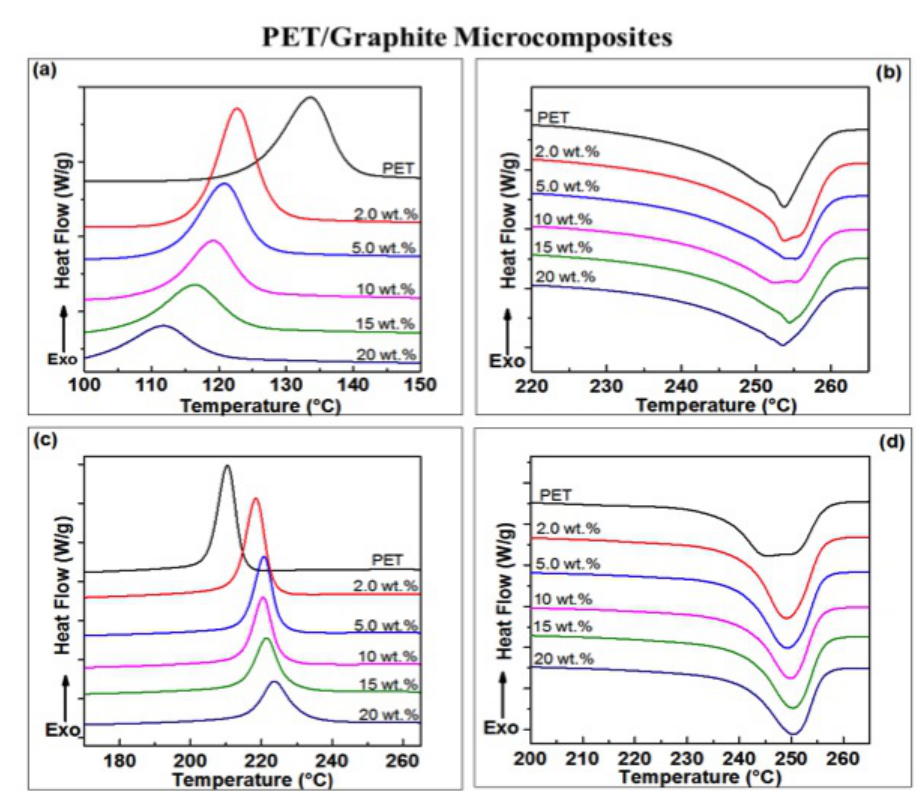
Figure 4. DSC curves (heating/cooling rate 10 ◦ C/min) for PET/graphite micro-composites show: ( a ) cold crystallization peaks; ( b ) melting peaks from the first scan; ( c ) subsequent cooling curves; and ( d ) melting peaks from the second heating